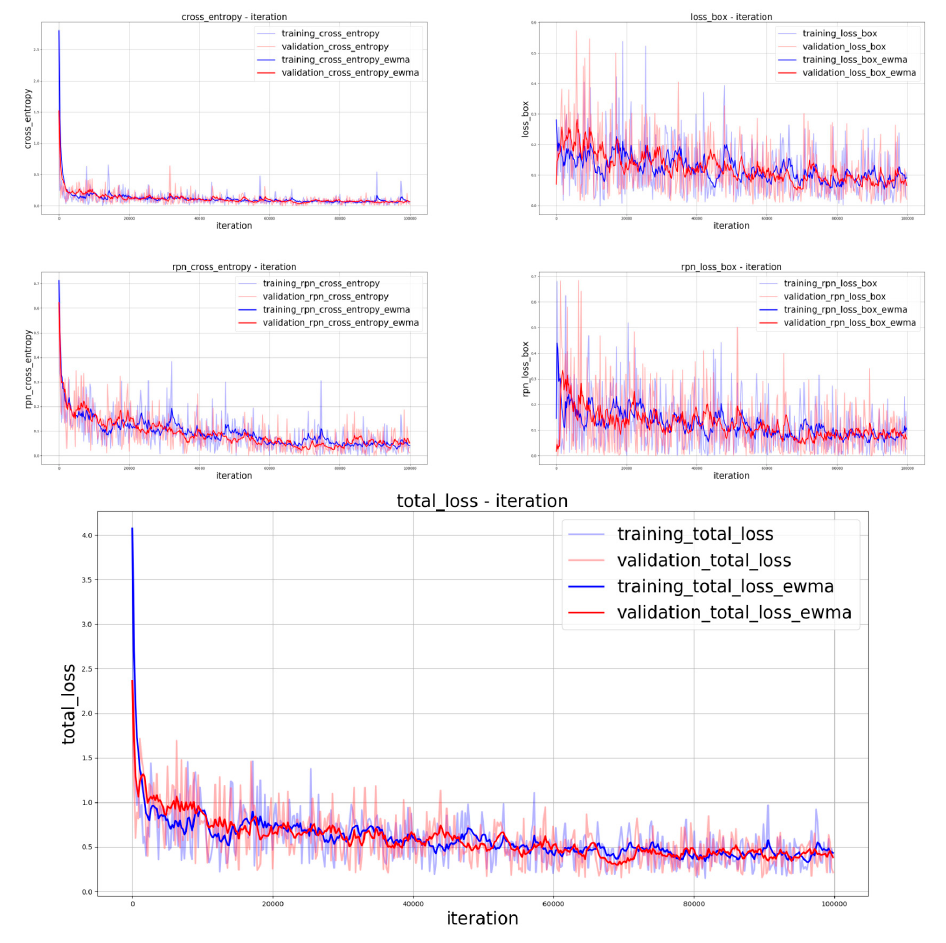
Figure 16. Training and validation loss of the Faster R-CNN [5] with VGG16 [1]. Upper left: Cross-entropy loss. Middle left: Region proposal network (RPN) cross-entropy loss. Upper right: Bounding box loss. Middle right: RPN bounding box loss. Bottom: Total loss.